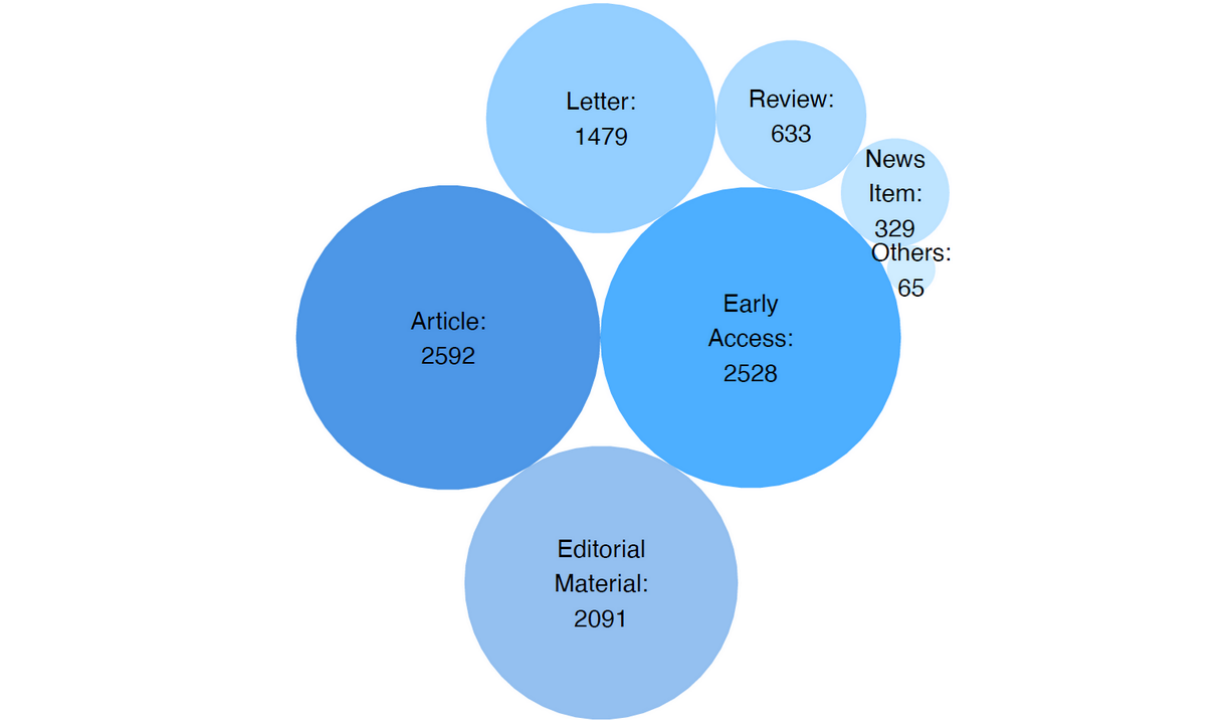
Figure 1. Publications included in the study. Bubble size reflects the number of instances of each item class.